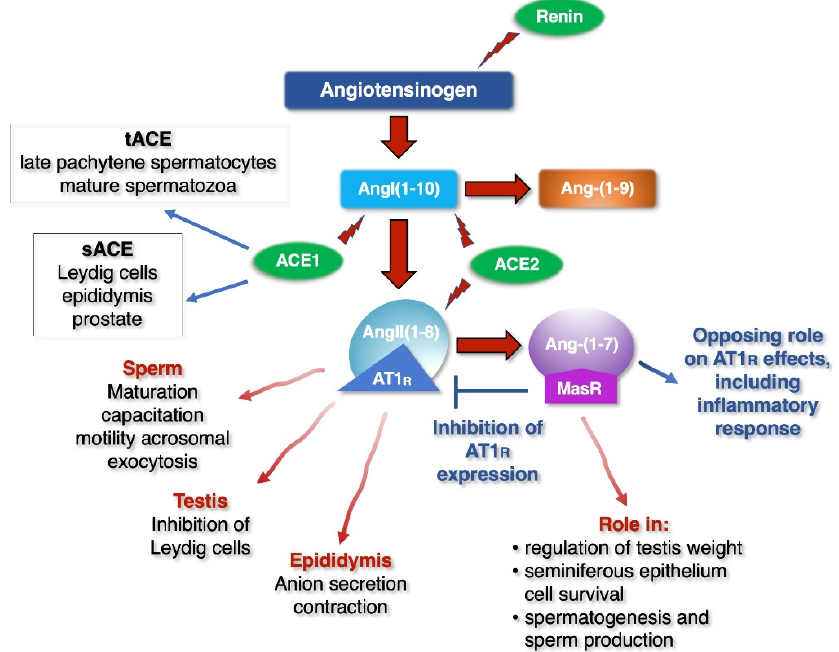
Figure 2. Simplified view of the renin–angiotensin system (RAS) in the male reproductive system. Schematic cartoon illustrating the renin–angiotensin system in the male reproductive system. The main components of the pathway and the main functions of the ligands and receptors are shown. Renin enzyme cleaves its substrate Angiotensinogen to form the decapeptide AngI, which is in turn cleaved by ACEI to produce AngII(1 − 8). The functions of AngII(1 − 8) in male reproductive events are stimulated by the AngII type 1 receptor (AT1R). For the details, see the text. Full red arrows indicate the enzymatic action on the substrate. The blue block arrow indicates the inhibition of MasR on AT1 R .